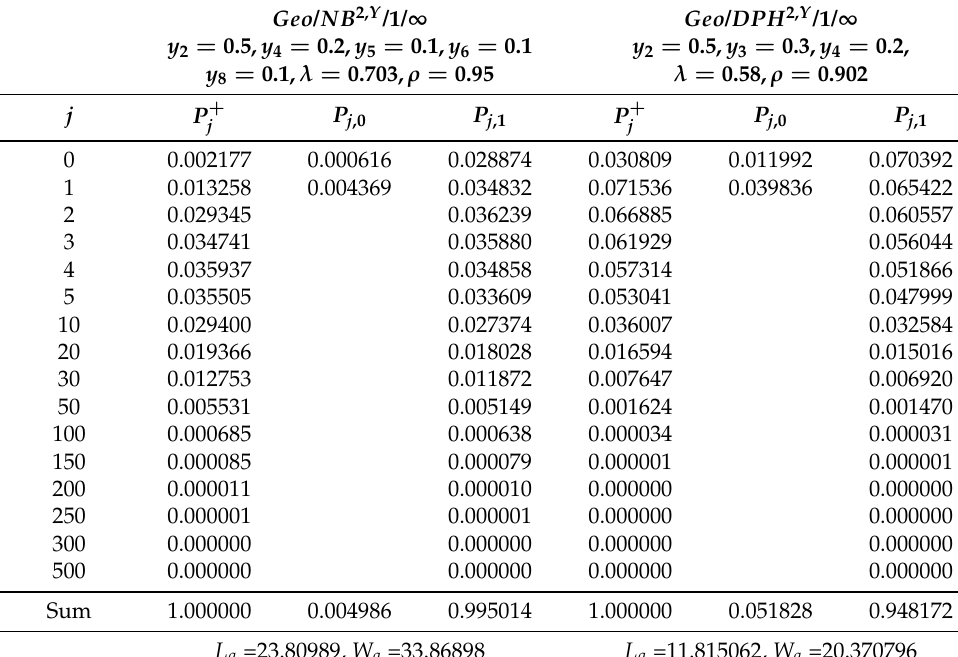
Table 4. Queue-length distributions at various epochs when N → ∞ .